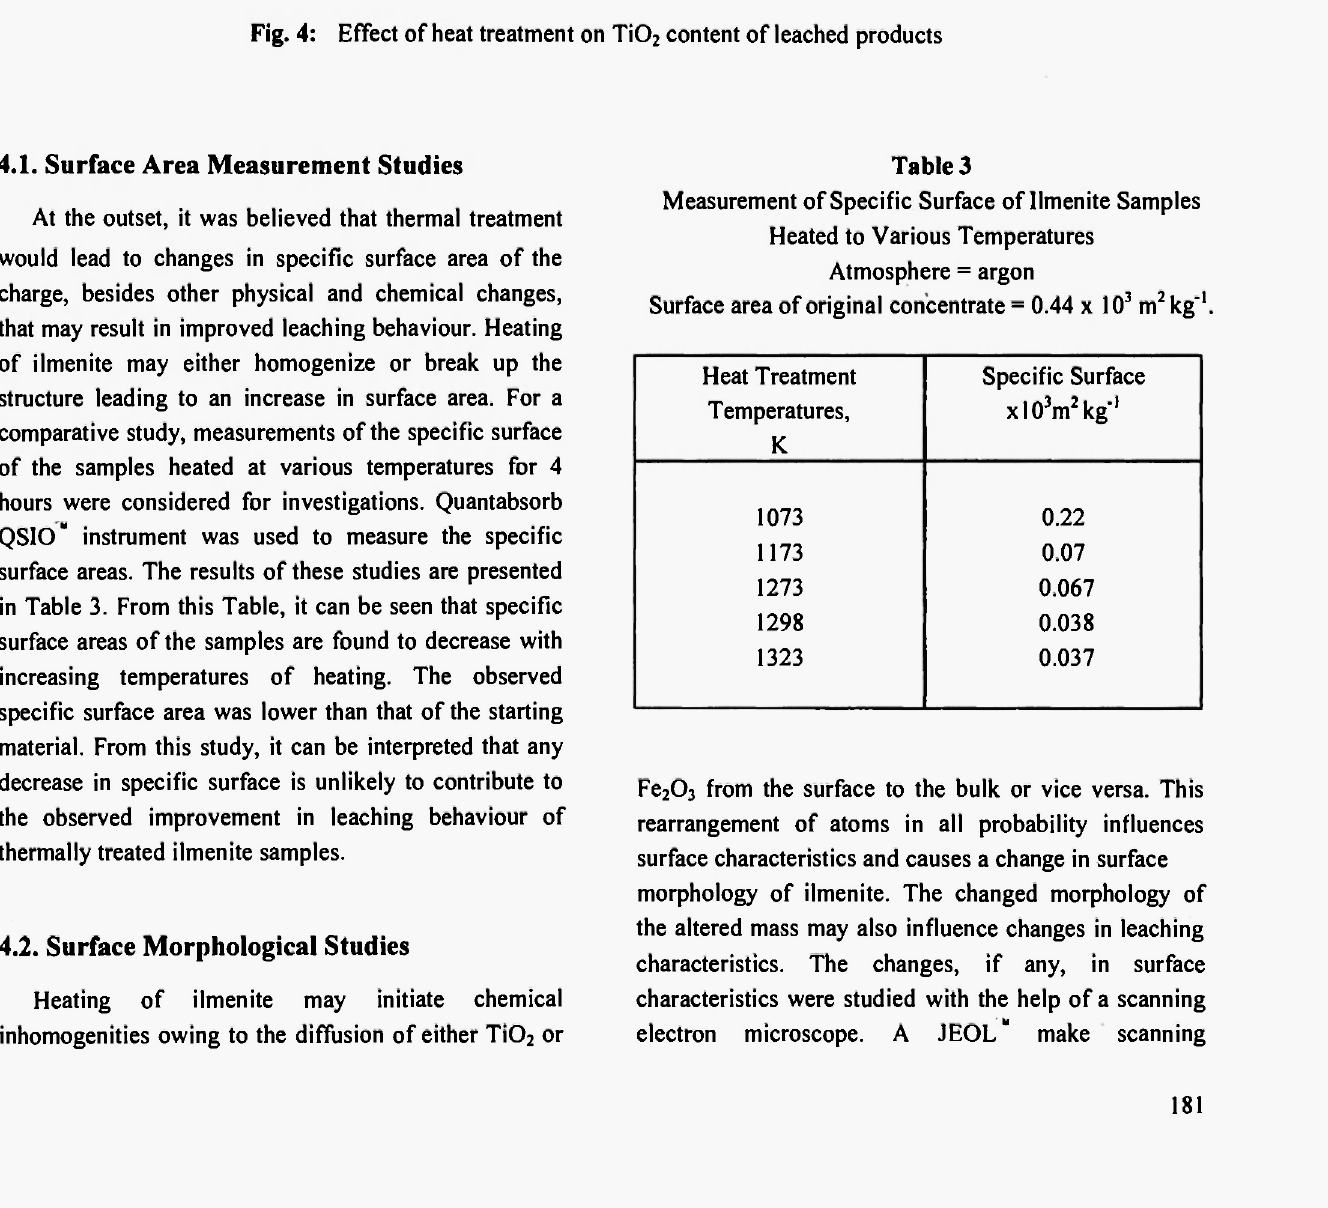
Fig. 4: Effect of heat treatment on Ti0 2 content of leached products